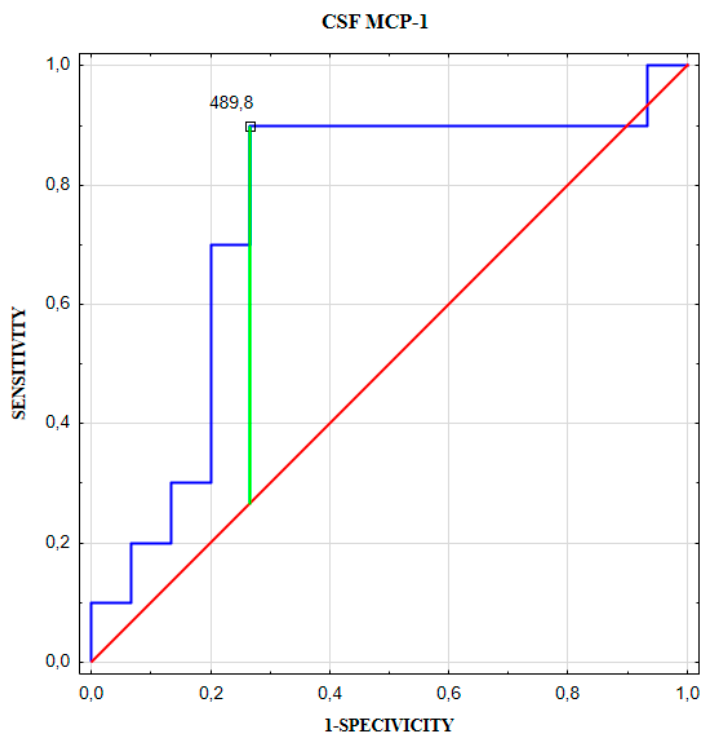
Figure 7. CSF MCP-1 receiver operator characteristic (ROC) curve for predicting a number of